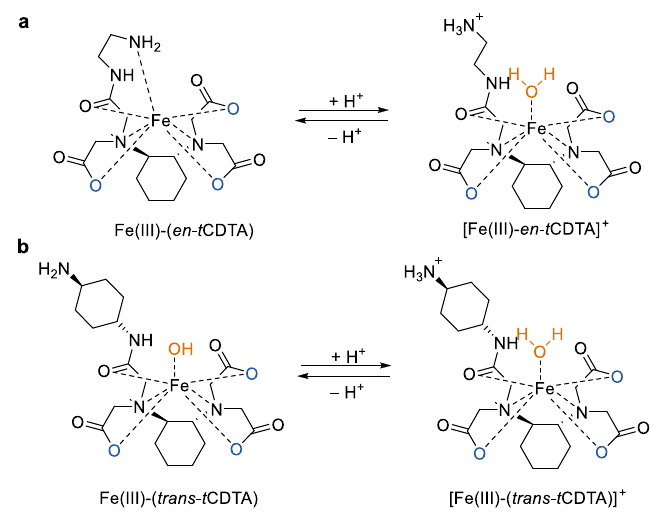
Figure 3. Chemical structures of mononuclear Fe(III) complexes with open ligands and their mechanisms of the observed pH-dependent relaxivity changes of the complexes. ( a ) Fe(III) complexes based on en - t CDTA and ( b ) Fe(III) complexes based on trans - t CDTA [35]. Deferasirox (DFX), commonly used iron sequestering agents in thalassemic patients